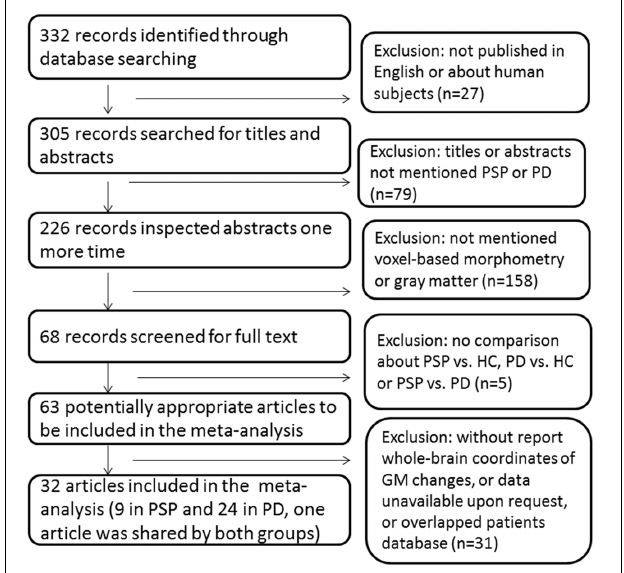
FIGURE 1 | Flow-chart of searching